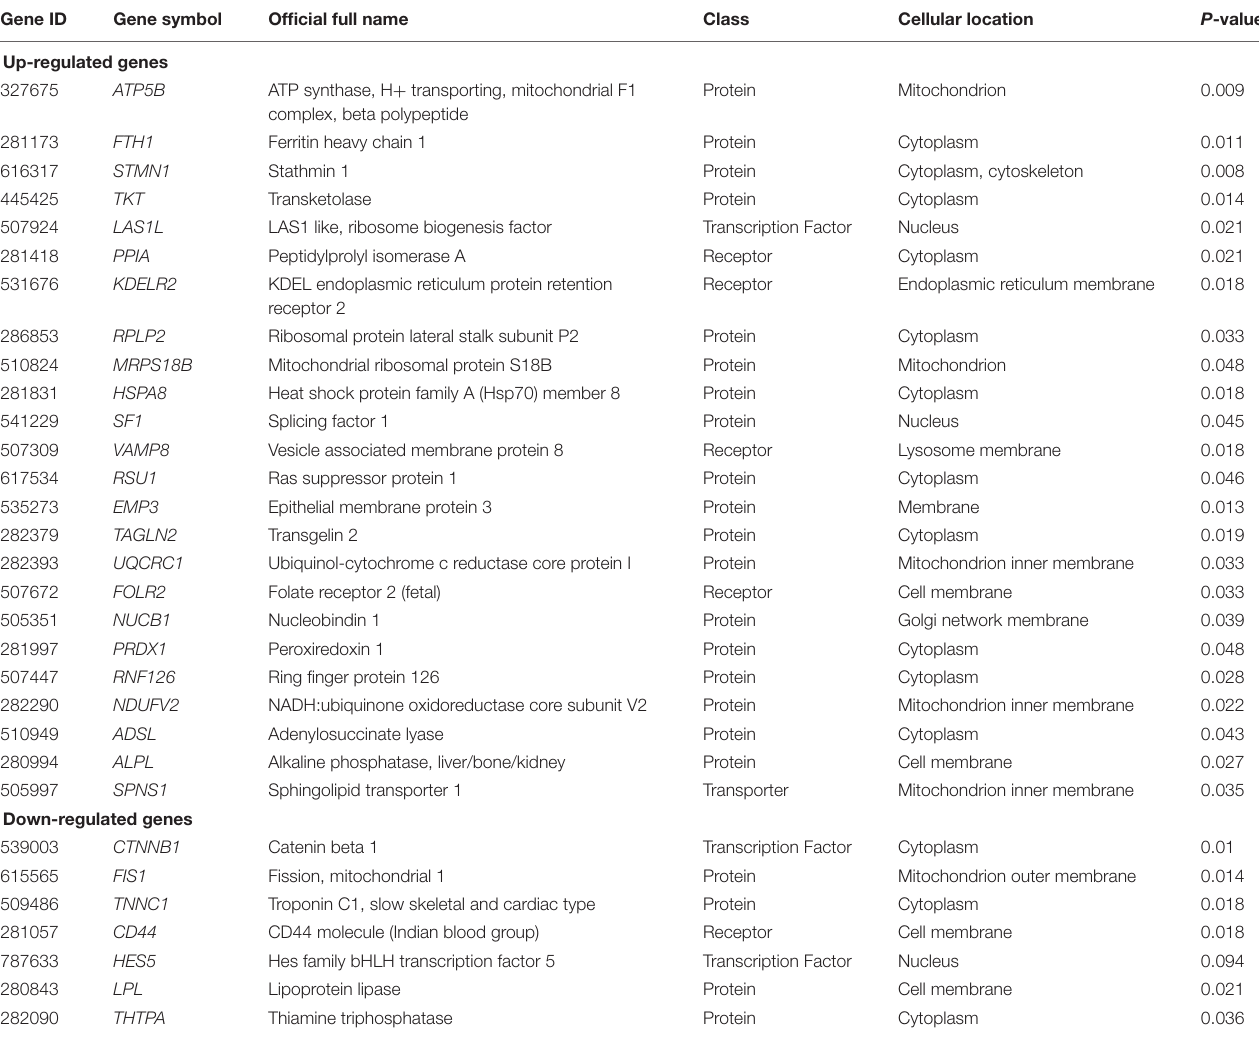
TABLE 2 | The detailed information of the discovered differentially expressed genes via meta-analysis in lactation